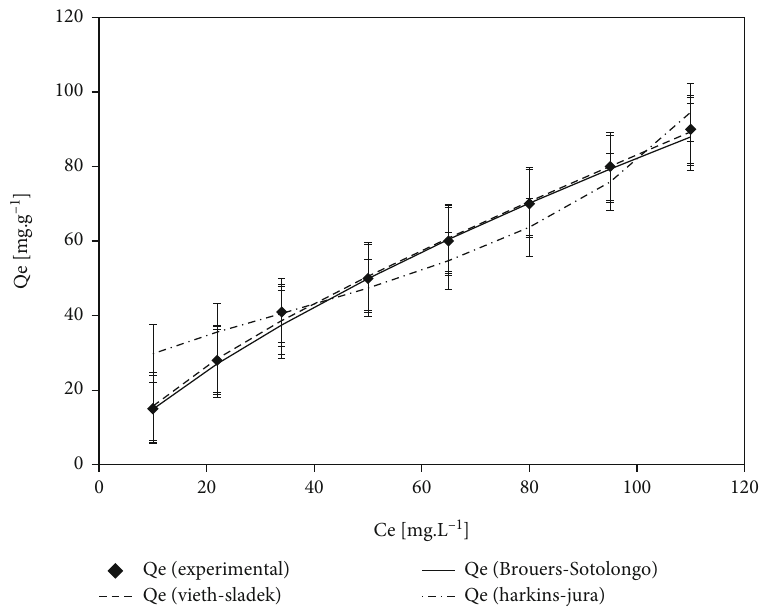
Figure 13: Adsorption data fi tting to Vieth-Sladek, Brouers-Sotolongo, and Harkins-Jura